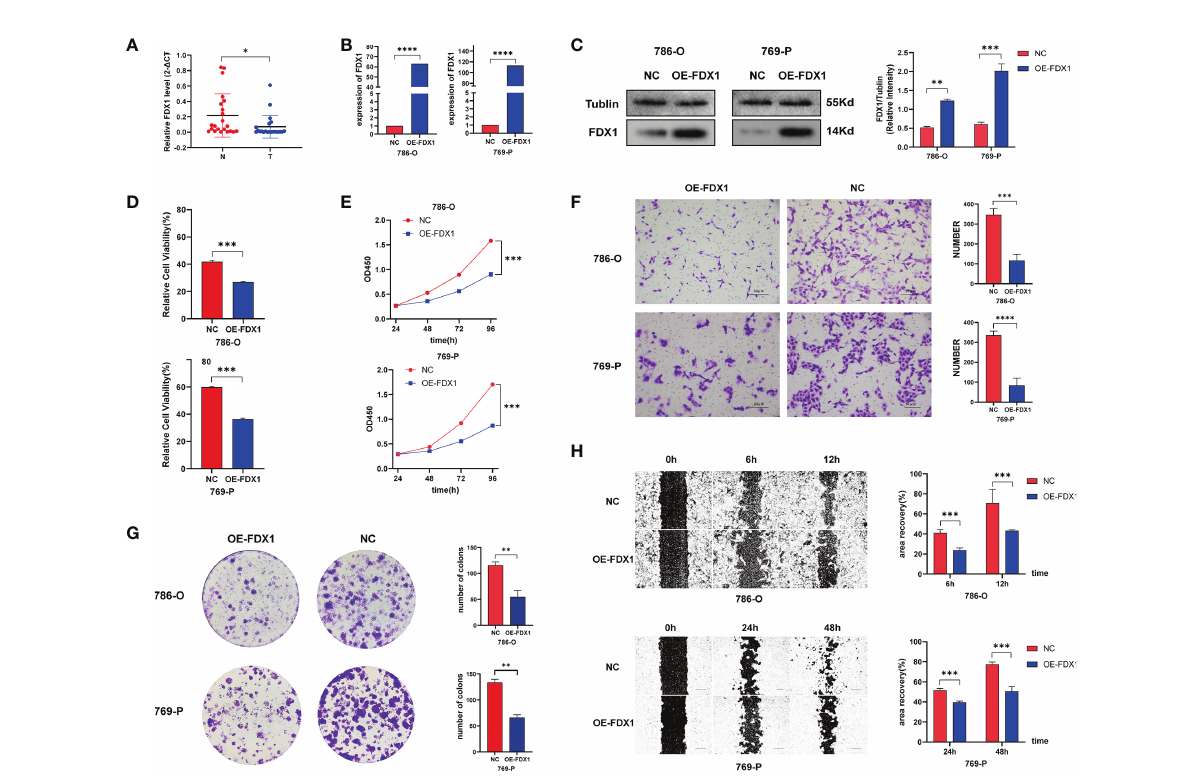
FIGURE 11 FDX1 regulates cuproptosis to suppress the progress of ccRCC. (A) FDX1 mRNA level in 23 paired clinical ccRCC samples. Overexpressing ef fi ciency of FDX1 in ccRCC cell lines validated by q-PCR (B) and Western blot (C) . (D) Relative viability of cells after being treated with elesclomol (20 nM) for 12 h. (E – H) CCK 8 assay (E) , colony formation assay (F) , Transwell assay (G) , and wounding healing assay (H) on ccRCC cells after transfection of plasmid vector carrying FDX1 ( p < 0.01 **; p < 0.001 ***; p < 0.0001